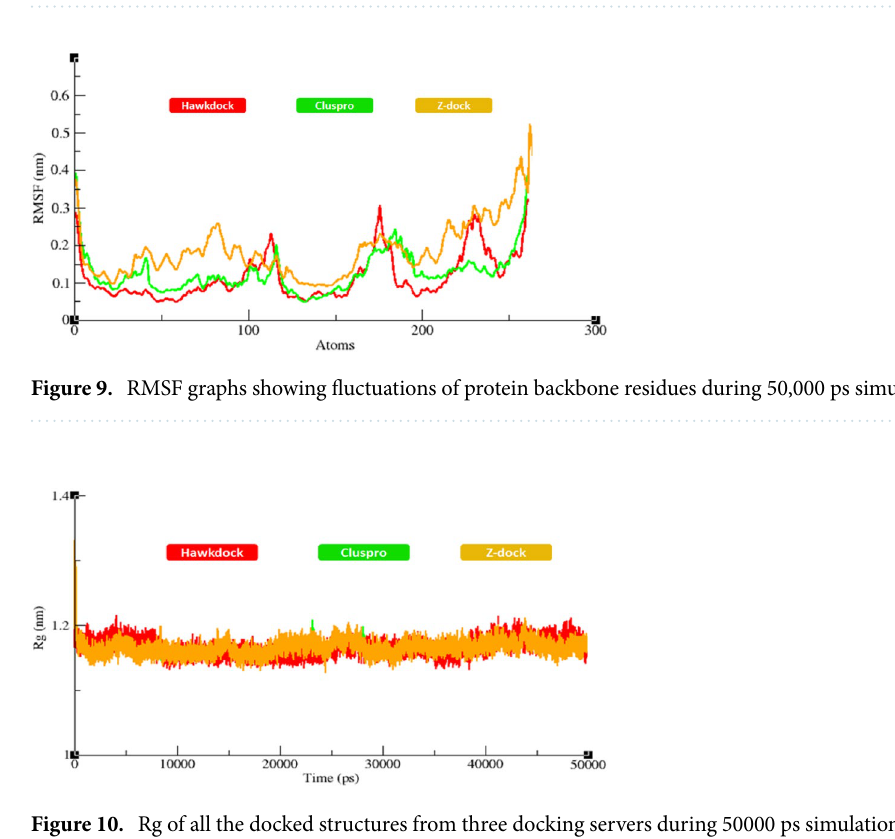
Figure 8. RMSD graph of all the docked structures during 50,000 ps simulation.